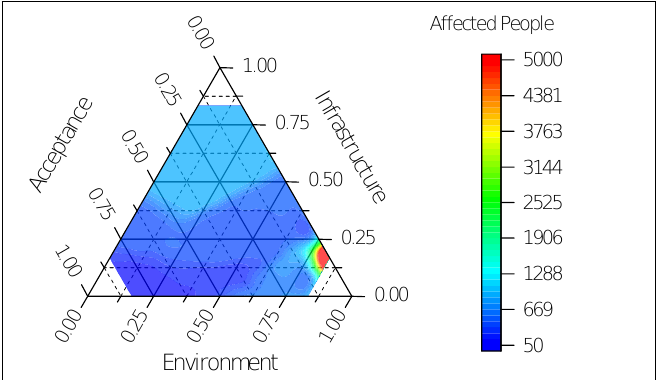
Figure 11. Influence of different weighting factors on the affected people for the DC SWE/FIN project. Own